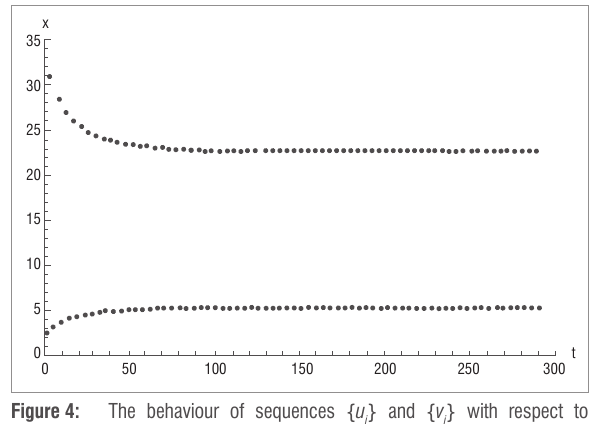
} ≈ 5.39 } ≈ 22.57 and lim { v j j j → n j → n